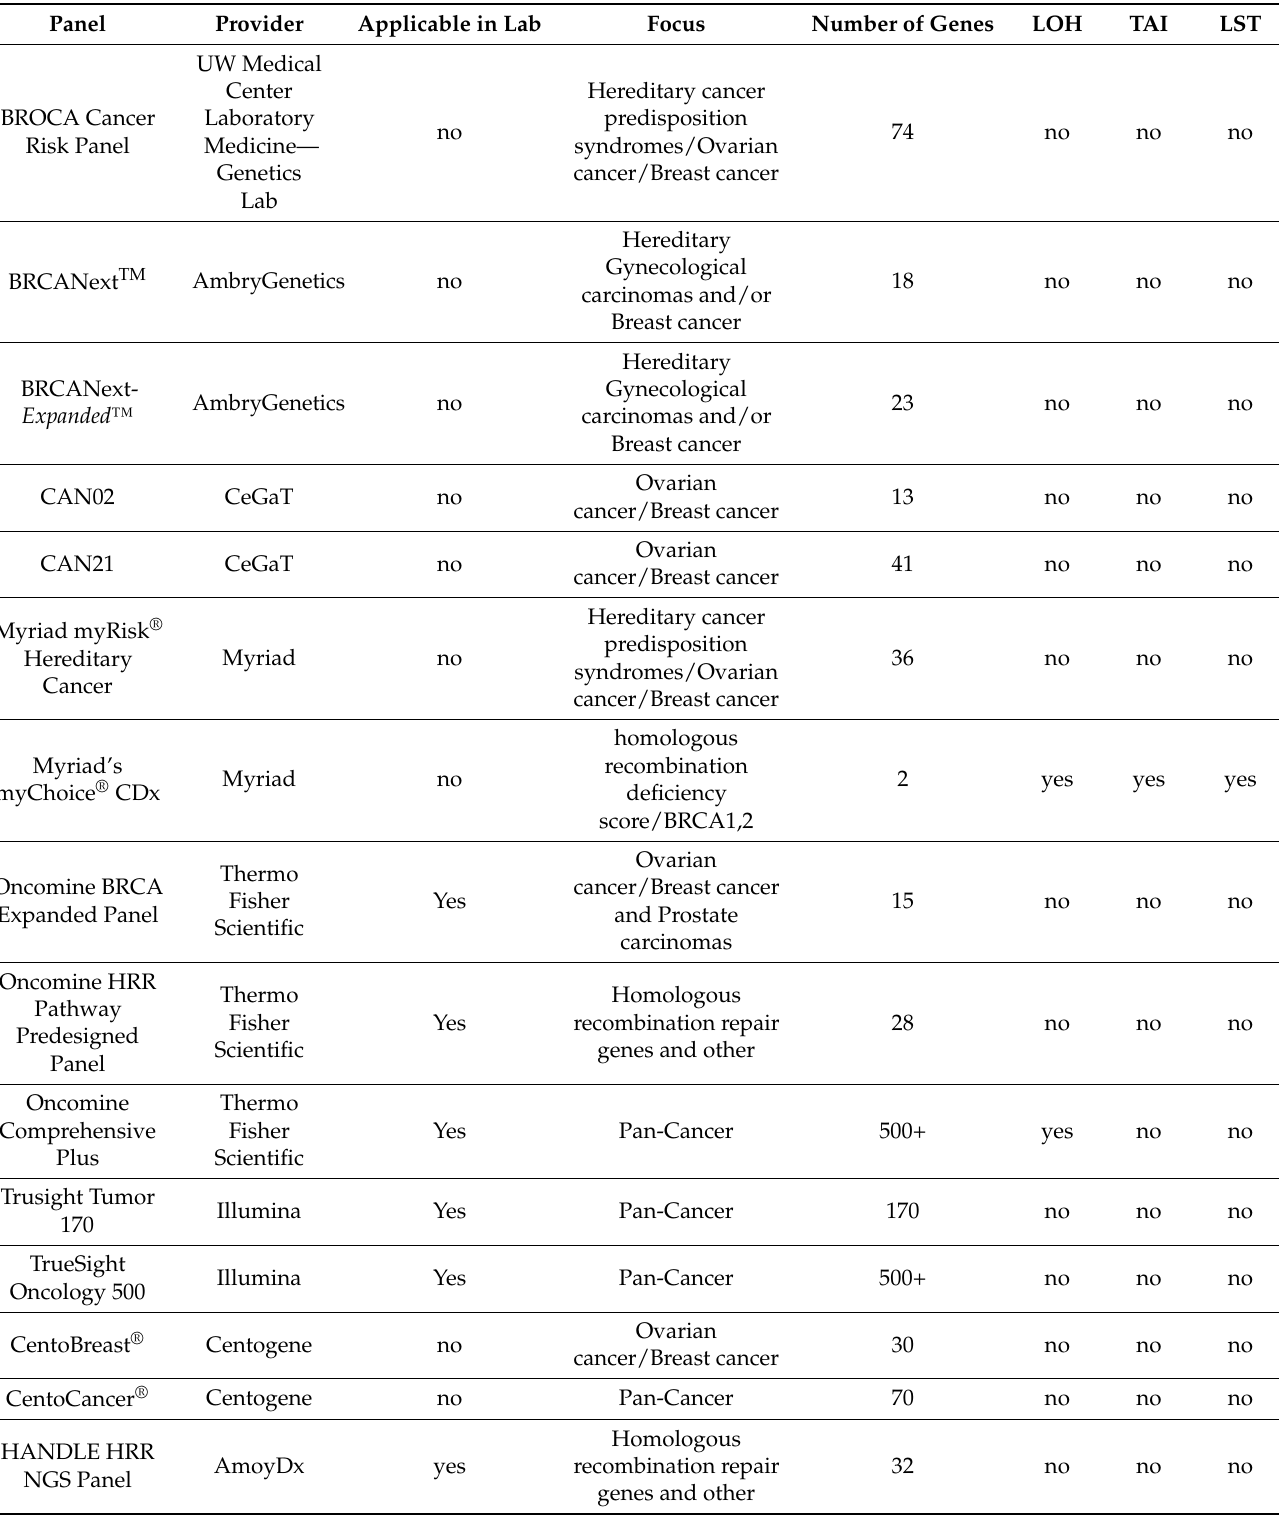
Table 1. Different panel for the detection of Homologous recombination repair (HRR) genes and homologous recombination deficiency (HRD) including loss of heterozygosity (LOH), telomeric allelic imbalance (TAI) and large scale state transitions (LST). Definitions of LOH, TAI and LST can be found in Section